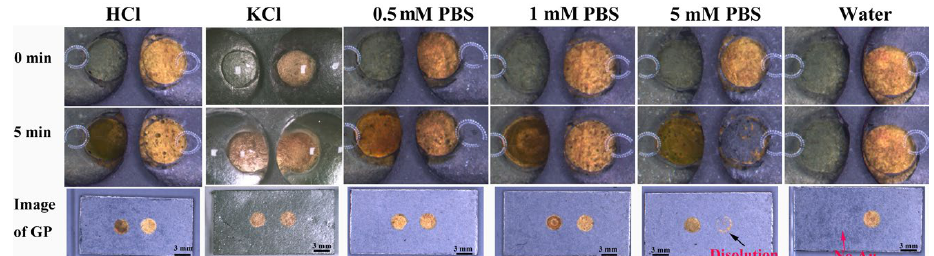
Figure 3. Deposition of Au at the cathode in the left reservoir. The anode was pre-deposited with Au at 4.5 V for 300 s. The left reservoirs were filled with 5 mM HAuCl 4 . ( A ) The right reservoir was filled with 5 mM HCl and 5 mM KCl, respectively. ( B ) The right reservoir was filled with ultra-pure water and different concentrations of PBS. Solutions were prepared with ultra-pure water unless otherwise specified.